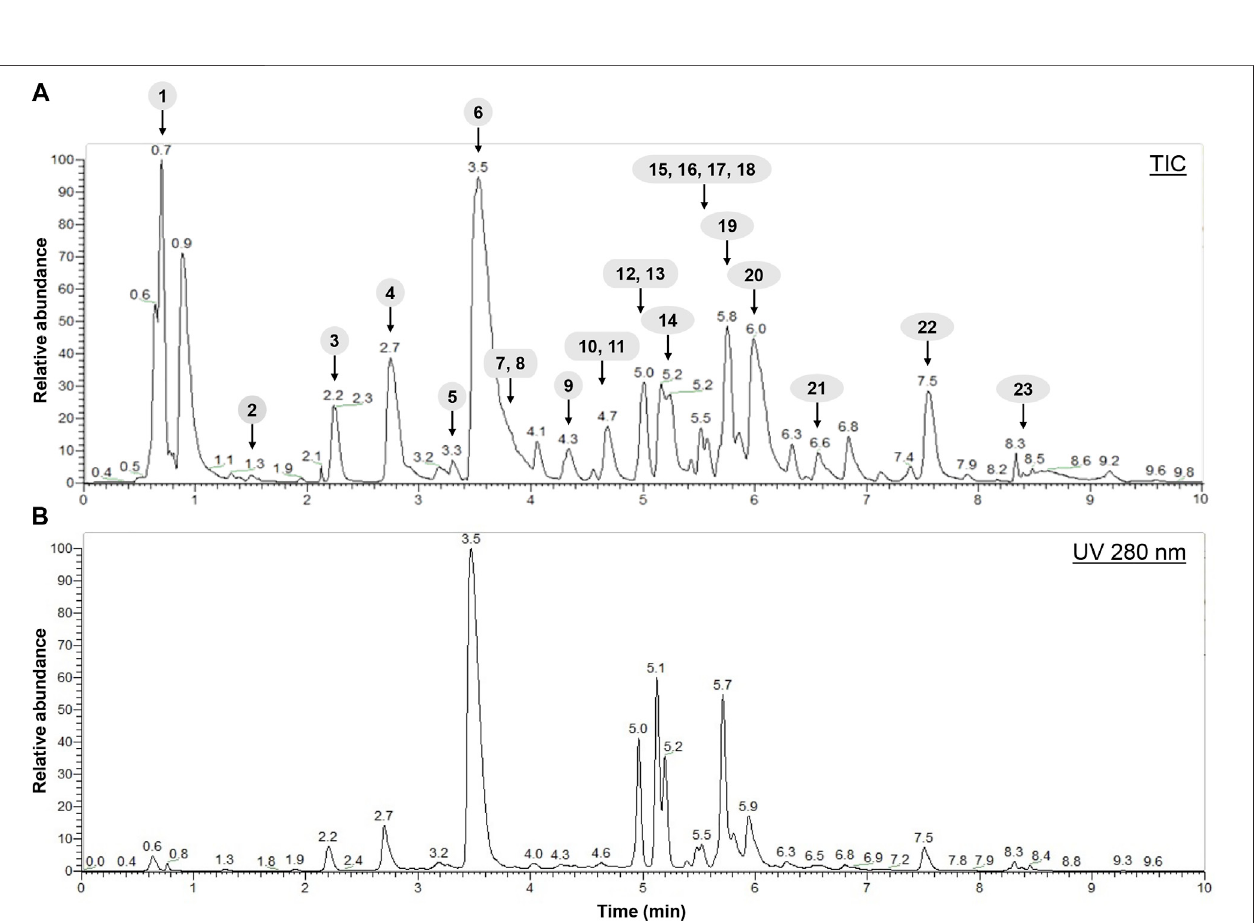
FIGURE1| Spectraobtainedaftercharacterizationof H.lanceolatum aqueousextractbyLC-MS/MS. (A) Representativetotalionchromatogram (TIC)obtainedin negative mode (B) HPLC-UV chromatogram obtained at 280 nm.